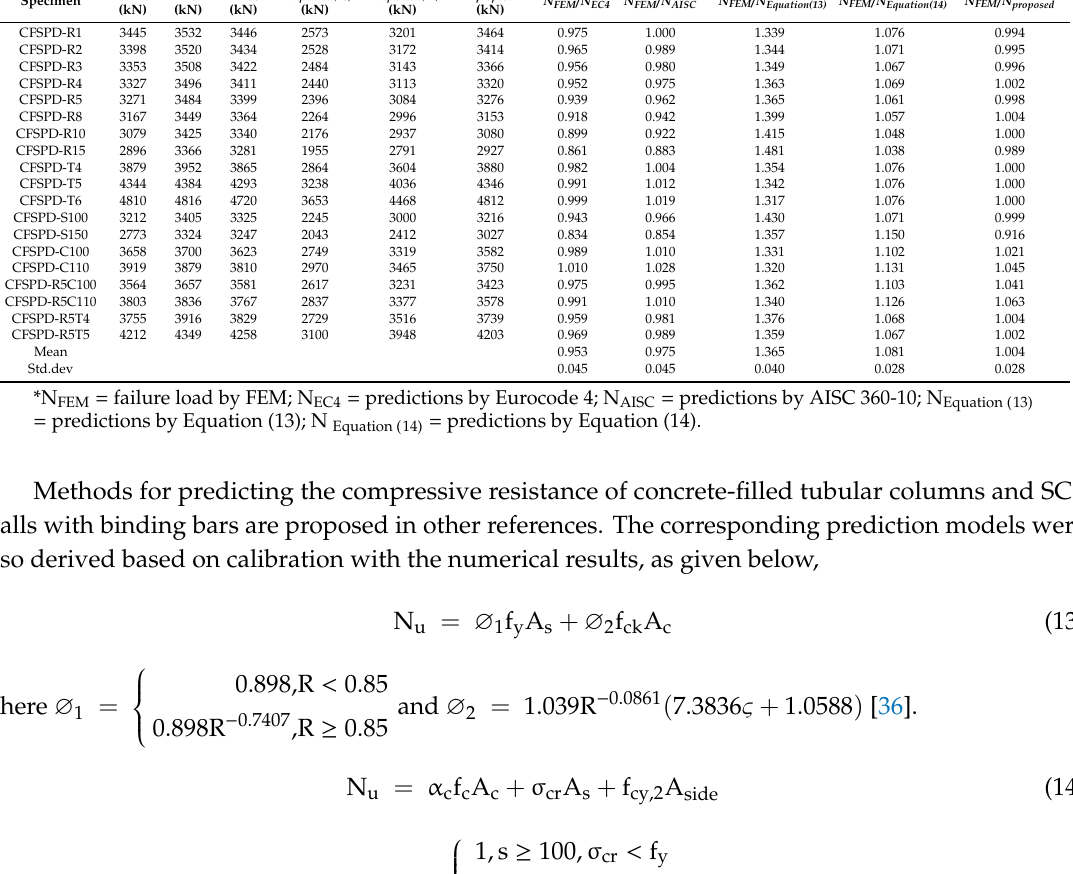
Table 3. Comparison of compressive resistance between calculated and numerical results.